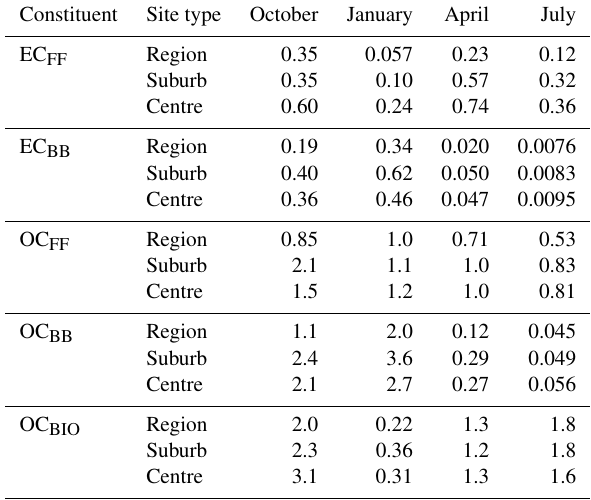
Table 4. Median atmospheric concentration of apportioned elemen- tal carbon from fossil fuel combustion (EC FF ) and from biomass burning (EC BB ), of apportioned organic carbon from fossil fuel combustion (OC FF ), from biomass burning (OC BB ) and from bio- genic sources (OC BIO ) in µgm − 3 for regional background in the Carpathian Basin, suburban area and city centre of Budapest for different months representing different